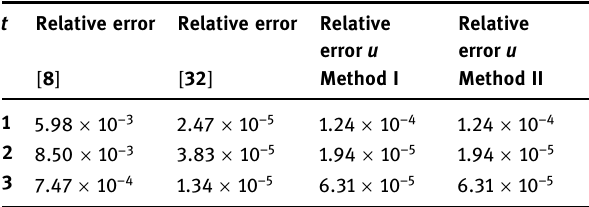
Boundary conditions are obtained from the following exact solution.